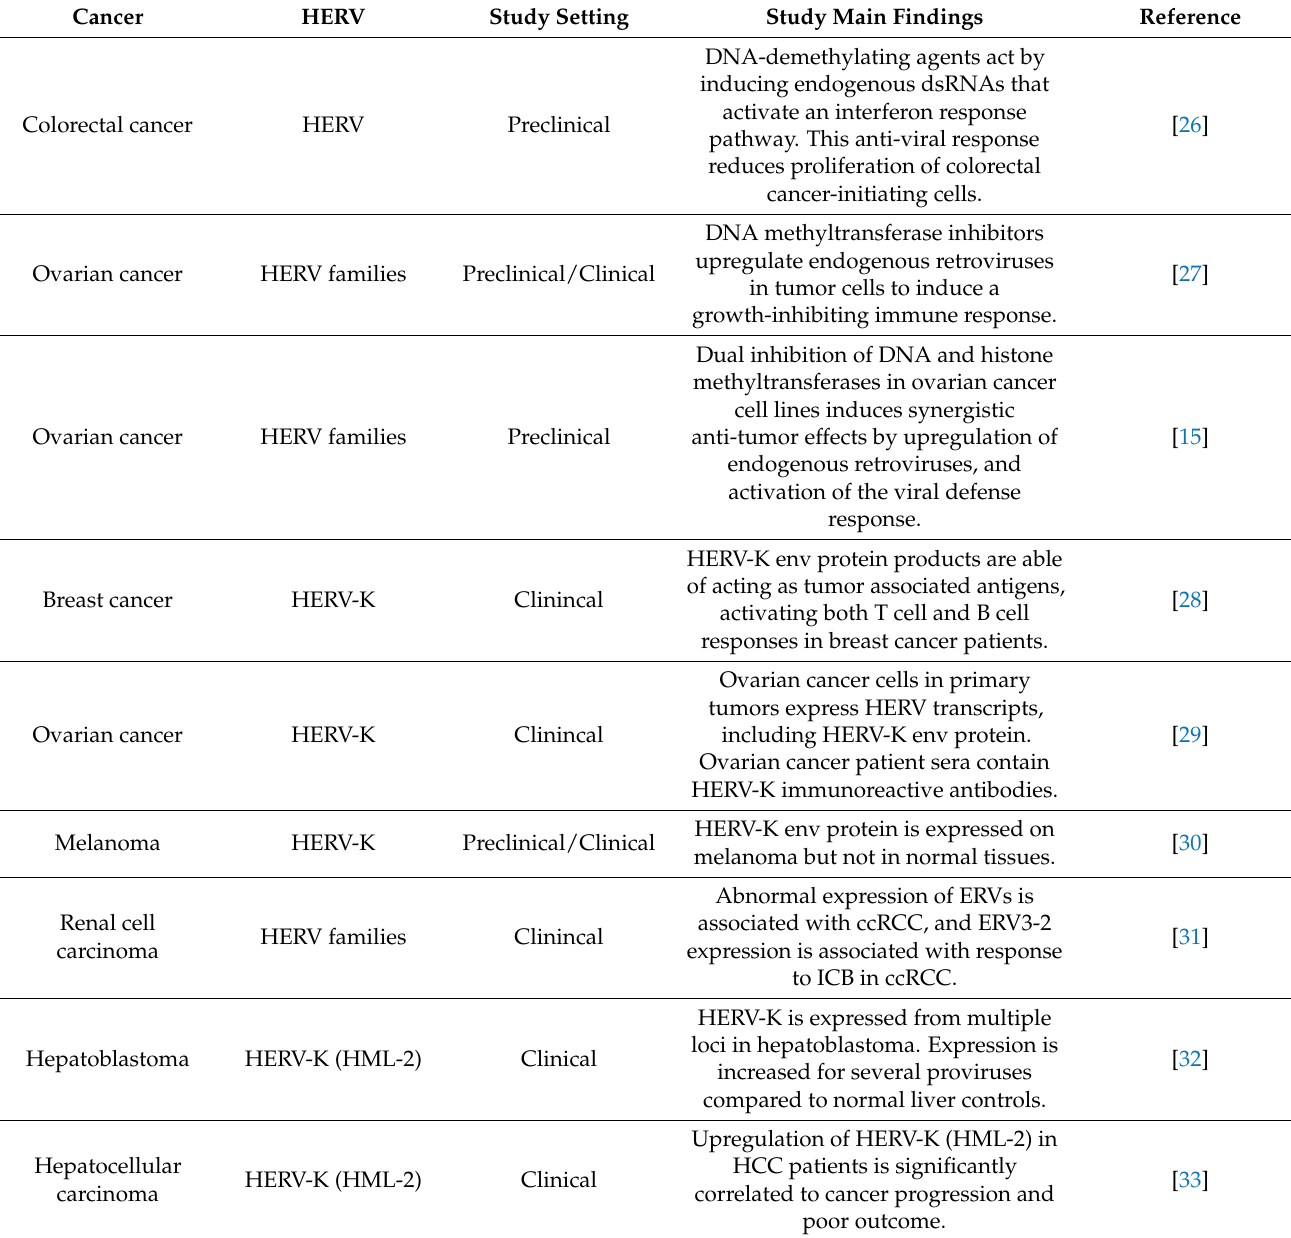
Table 2. Studies reporting HERV expression in